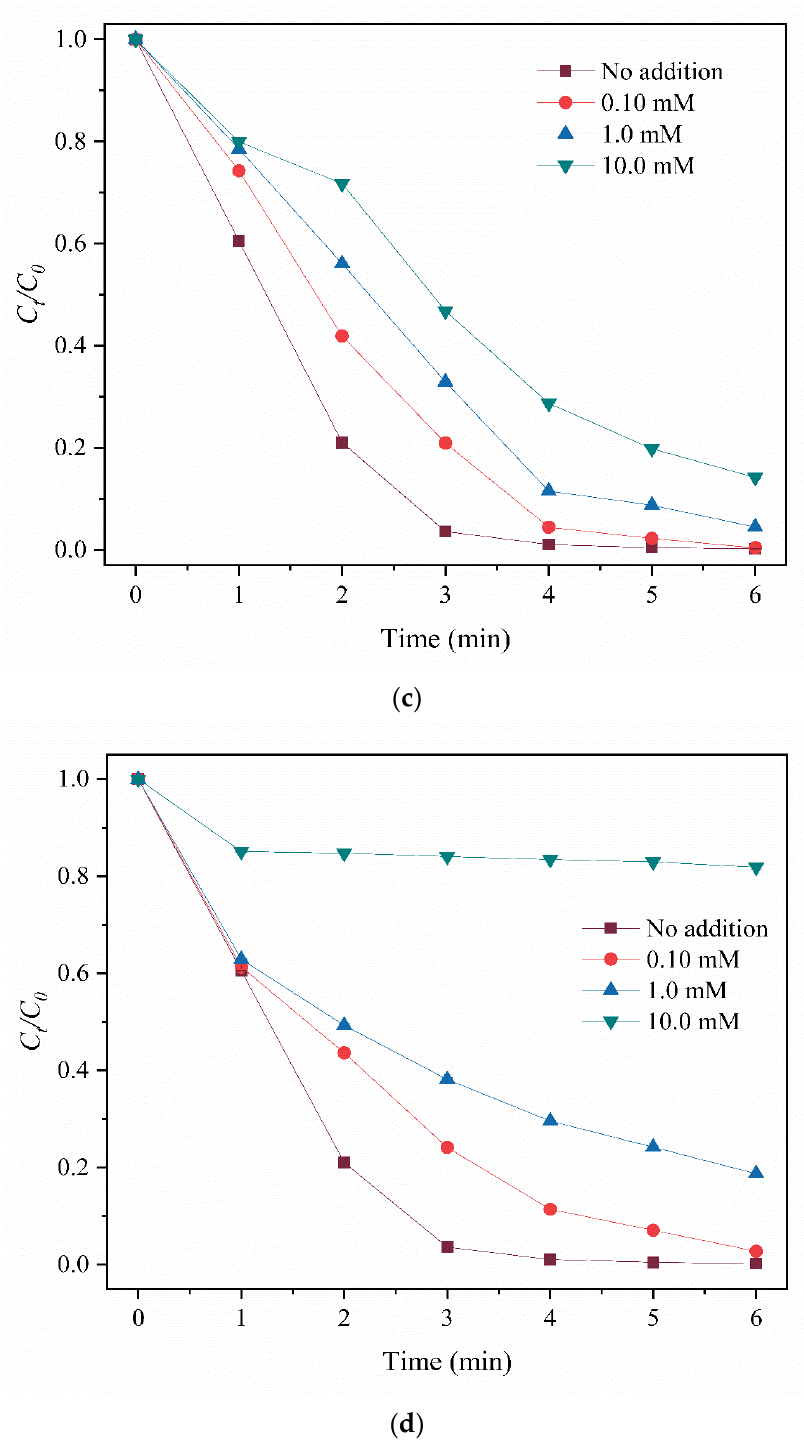
Figure 6. Effects of different scavengers on RhB removal. MeOH ( a ), IPA ( b ), p-BQ ( c ) and L-Histidine ( d ). Reaction conditions: [PMS] =1.0 mM, [CM/g-C 3 N 4 ] = 0.30 g/L, [RhB] = 10.0 mg/L, 25 °C.